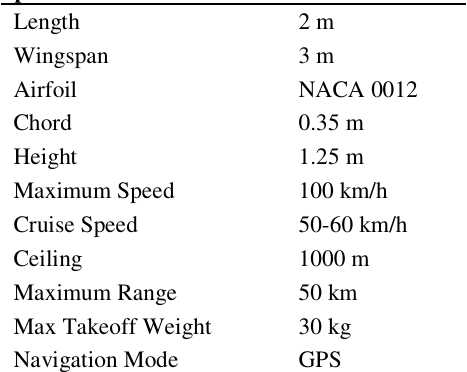
Specification of UAV.